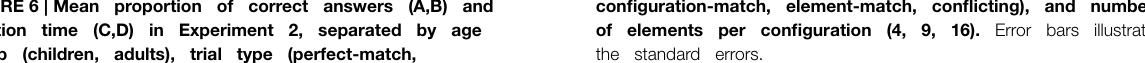
configuration-match, element-match, conflicting), and number of elements per configuration (4, 9, 16). Error bars illustrate the standard